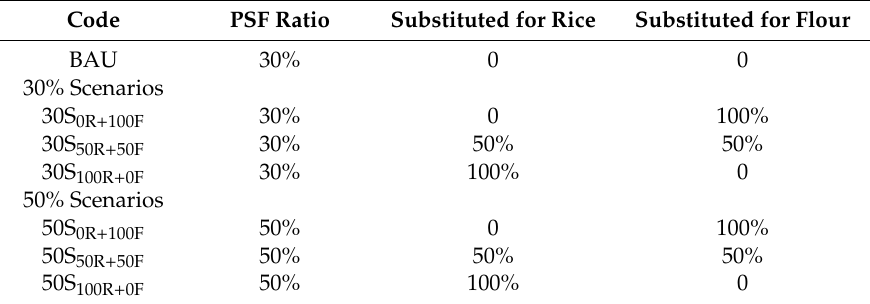
BAU: business as